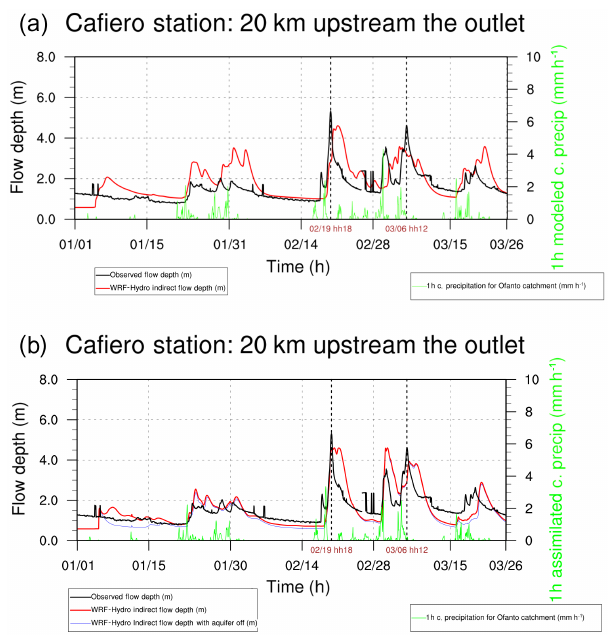
Figure 9. Validation of the Ofanto discharge for Experiment 1 at Cafiero station. (a) Modelled precipitation. (b) Assimilated precip- itation. The blue time series refers to the additional experiment per- formed with the aquifer switched